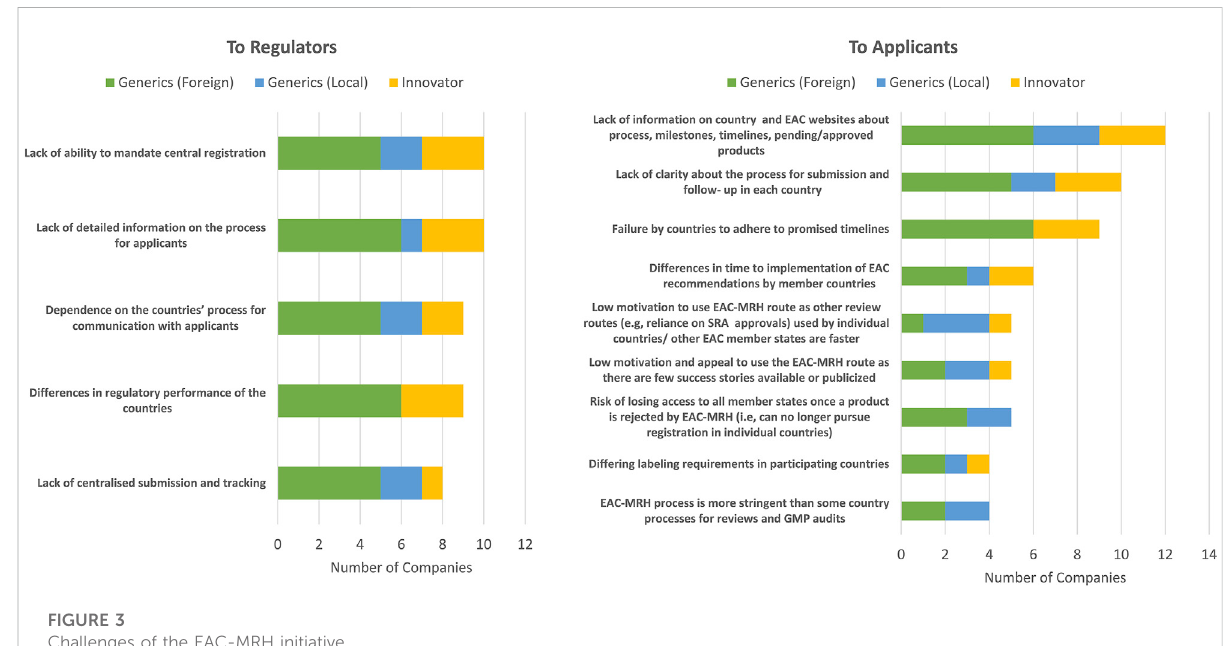
FIGURE 3 Challenges of the EAC-MRH